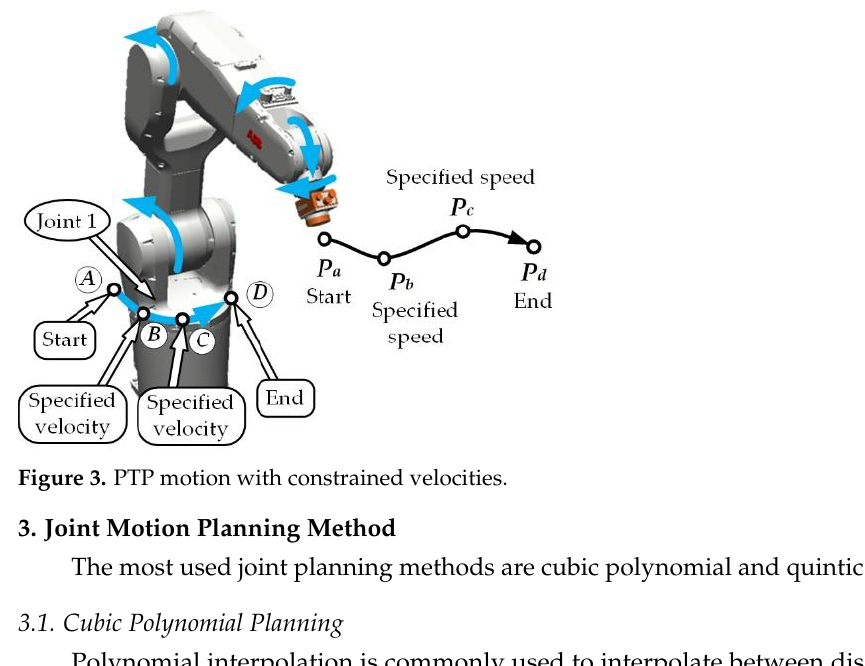
The most used joint planning methods are cubic polynomial and quintic